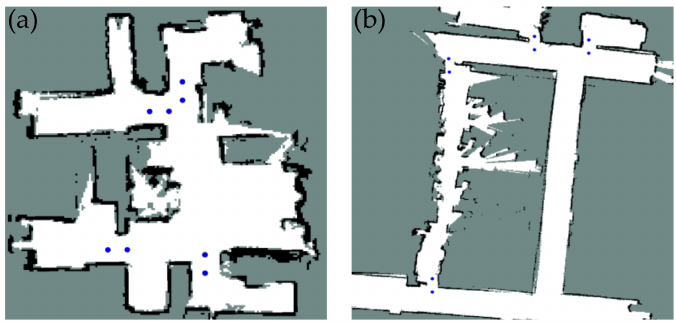
Figure 9. Auxiliary Navigation Points: ( a ) home scene. ( b ) o ffi ce scene.